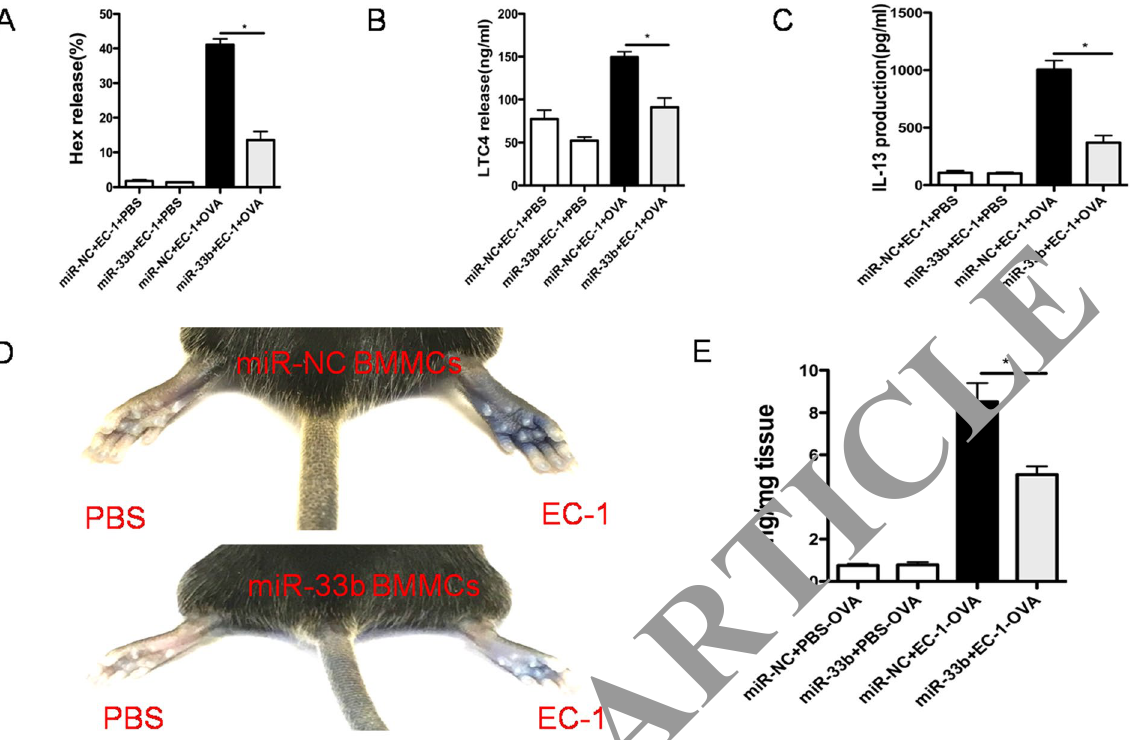
Figure 5. MiR-33b significantly decreased mast cell degranulation and PCA reactions. ( A ) BMMCs from C57BL/6 mice were sensitized with 1 μ g/ml OVA IgE (E-C1) for 24 h and then stimulated with 10 μ g/ml OVA for 30 min. Degranulation was monitored as the release of β -hexosaminidase. ( B , C ) miR-33b decreased the IgE-mediated LTC4 and IL-13 production. ( D ) Representative images of Evans blue-stained extravasation into the paws 30 min after intravenous injection of OVA in C57BL/6 mice treated with miR-NC BMMCs or miR- 33b BMMCs (n = 6 each group). ( E ) Quantification of the extravasation of Evans blue leakage into the paws. The absorbance was measured at 620 nm, and the data are expressed as Evan’s blue in ng/mg tissue. The data are presented as the means ± SEM. Comparisons between miR-NC BMMC- and miR-33b BMMC-transfected C57BL/6 mice were performed using two-tailed Student’s t-test. * P <